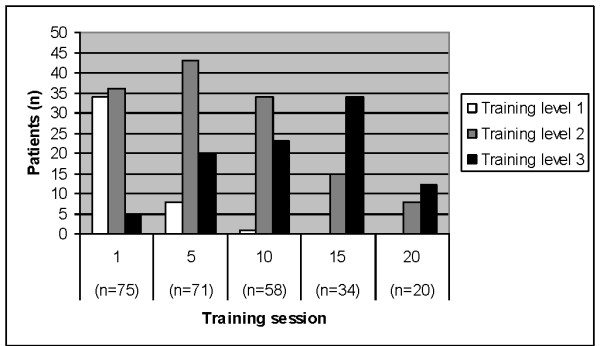
Progression of level of training during the training period. The number of patients training at levels 1, 2, and 3 at training sessions 1, 5, 10, 15 and 20. Note that the number of patients is reduced over time since the patients attended training until surgery, and the time from start of training to surgery was dependent on the waiting list and was not pre-defined in the study. Data for training level is missing for one patient.